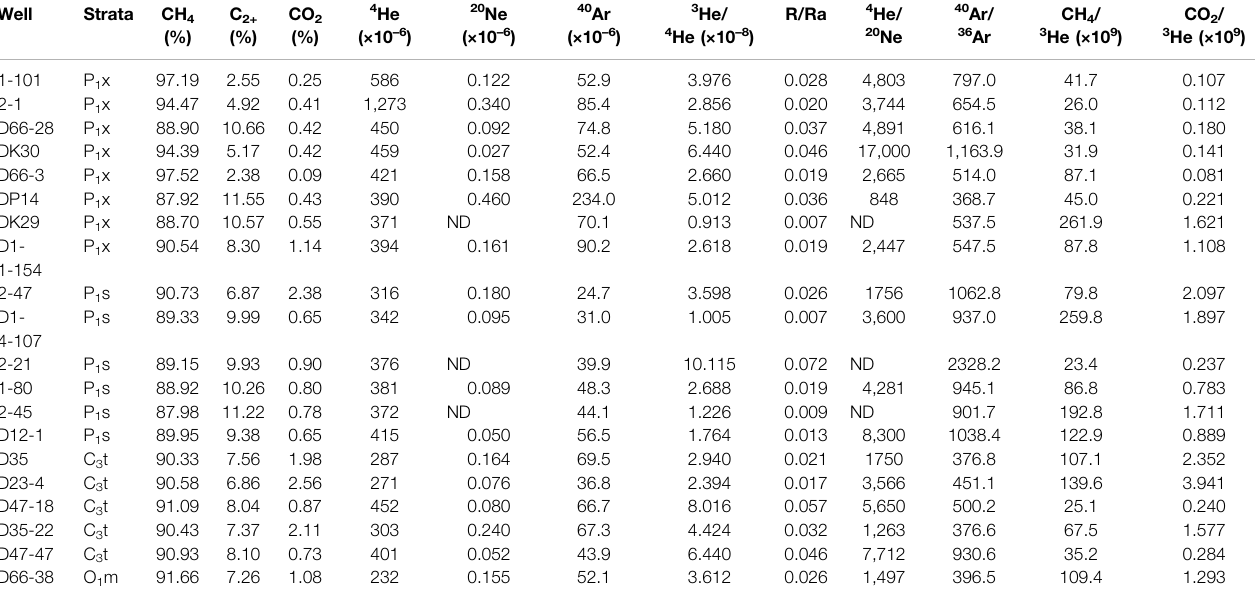
TABLE 1 | Noble gas concentrations and isotopic compositions of natural gas in the Daniudi gas fi eld, Ordos Basin. Well